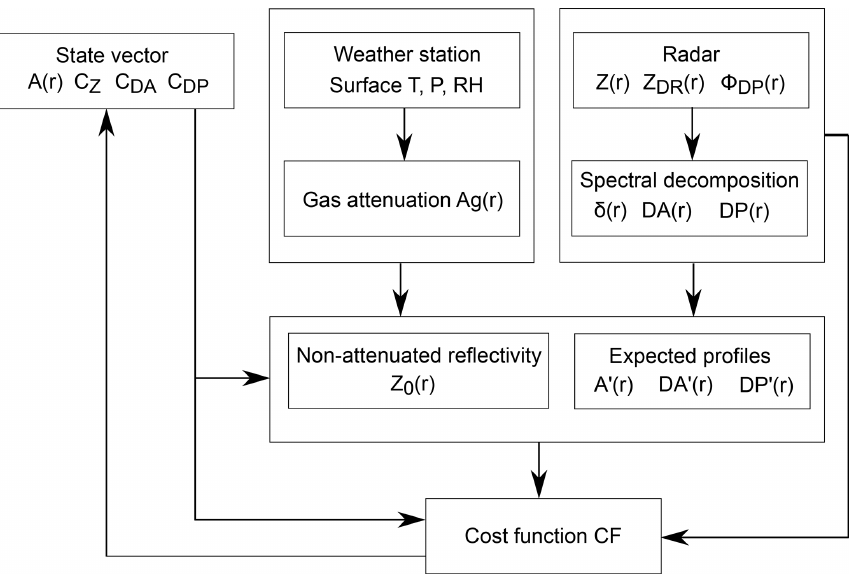
Figure 6. Schematic illustrating the processing steps of the self-consistency method. A detailed description can be found in the text.